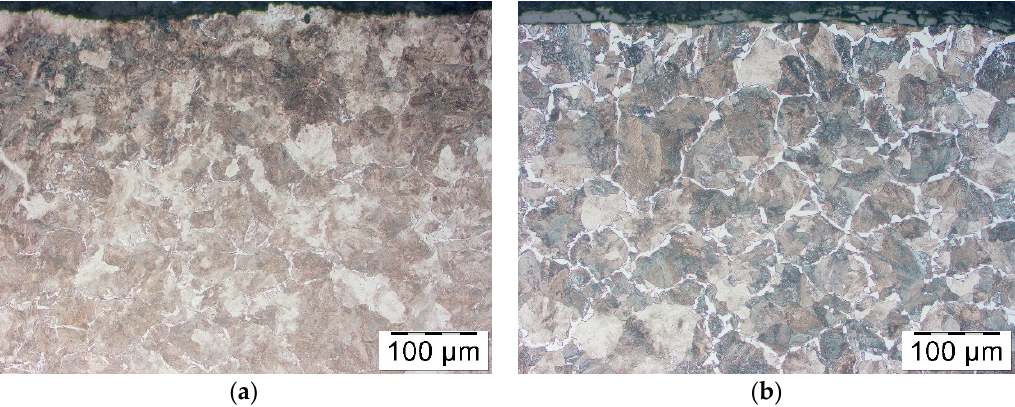
Figure 11. Microstructure in the surface layer of the forged part after hot forging and cooling—pre-coating of Bonderite in the concentration ( a ) 66% and ( b ) 50%.